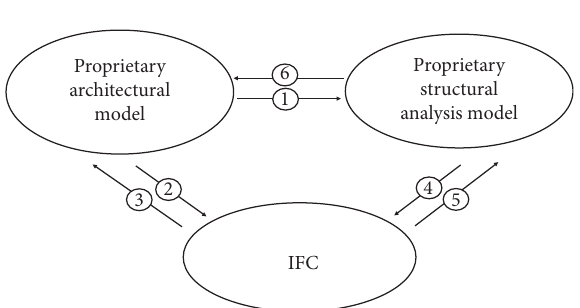
Figure 2: Six technical route segments of interoperability between architectural design and structural